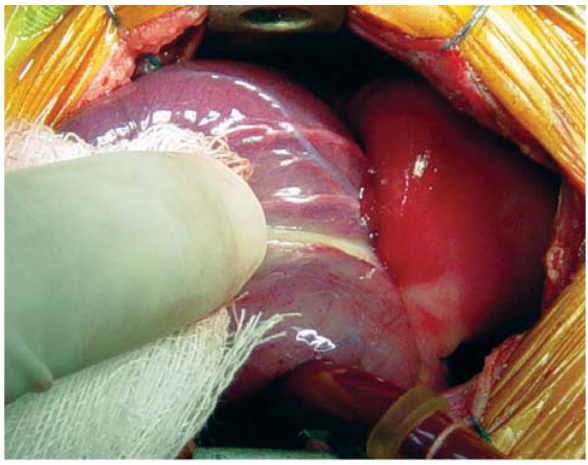
Fig. 2 – Aspecto da massa pediculada ao sulco atrioventricular posterior e não aderida ao